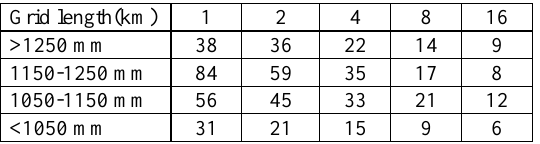
Table 3. Statistical results of the spatial distribution box dimension of disaster points zoned according to annual rainfall